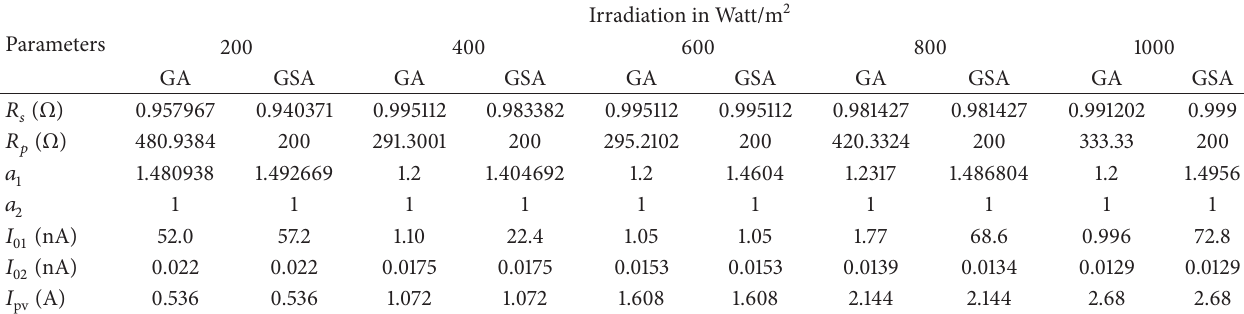
Table 2: Comparison of optimization results of GA and GSA at different irradiation levels for Shell ST40.